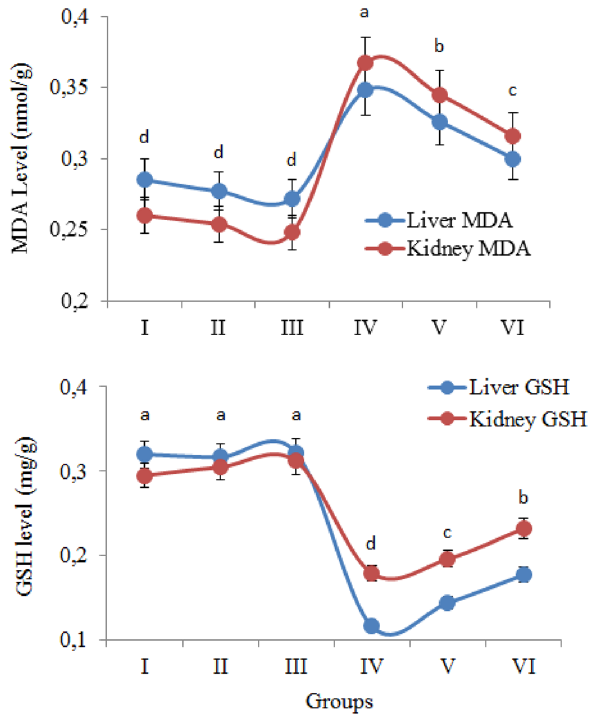
Figure 2. The effect of AFM 1 and t-rsv on MDA and GSH levels. Group I: Control, Group II: 10 mg/kg b.w. t-rsv, Group III: 20 mg/kg b.w. t-rsv, Group IV: 16 mg/kg b.w. AFM 1 , Group V: 10 mg/kg b.w. t-rsv + 16 mg/kg b.w. AFM 1 , Group VI: 20 mg/kg b.w. t-rsv + 16 mg/kg b.w. AFM 1. Different letters (a–d) indicated averages p < 0.05 are